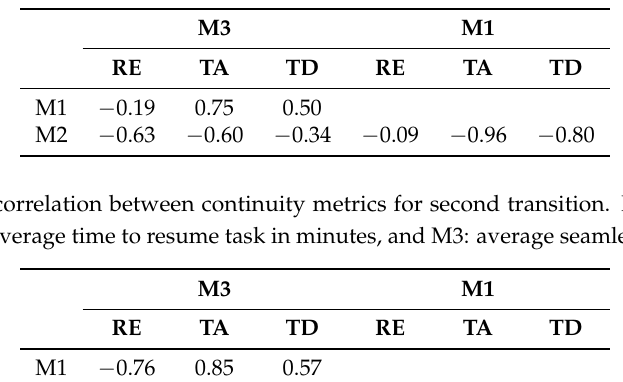
Table 4. Pearson correlation between continuity metrics for first transition. M1: task-resuming success rate, M2: average time to resume task in minutes, and M3: average seamless transition.